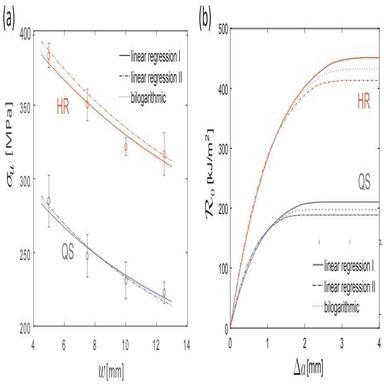
(a) Size effect law and (b) R-curves for QS and HR loading in compression.